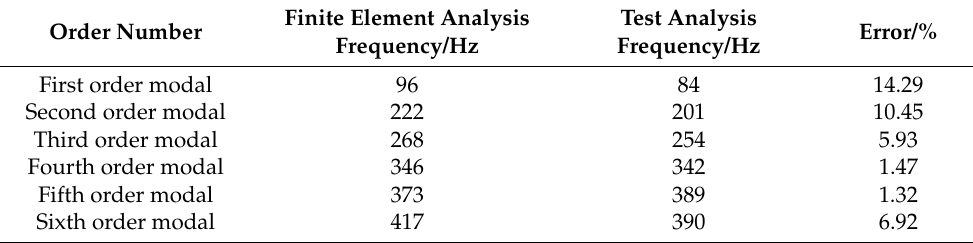
Table 9. The results of free modal finite element analysis of aluminium alloy front subframe are compared with the results of test